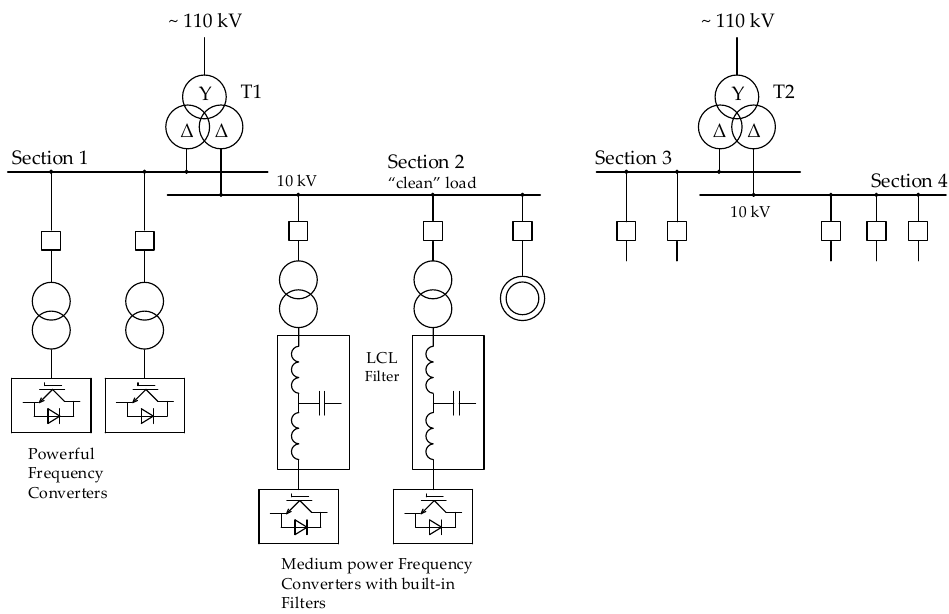
Figure 20. An example of using a “dirty section” to assure the electromagnetic compatibility of FC- AFEs and sensitive power consumers.